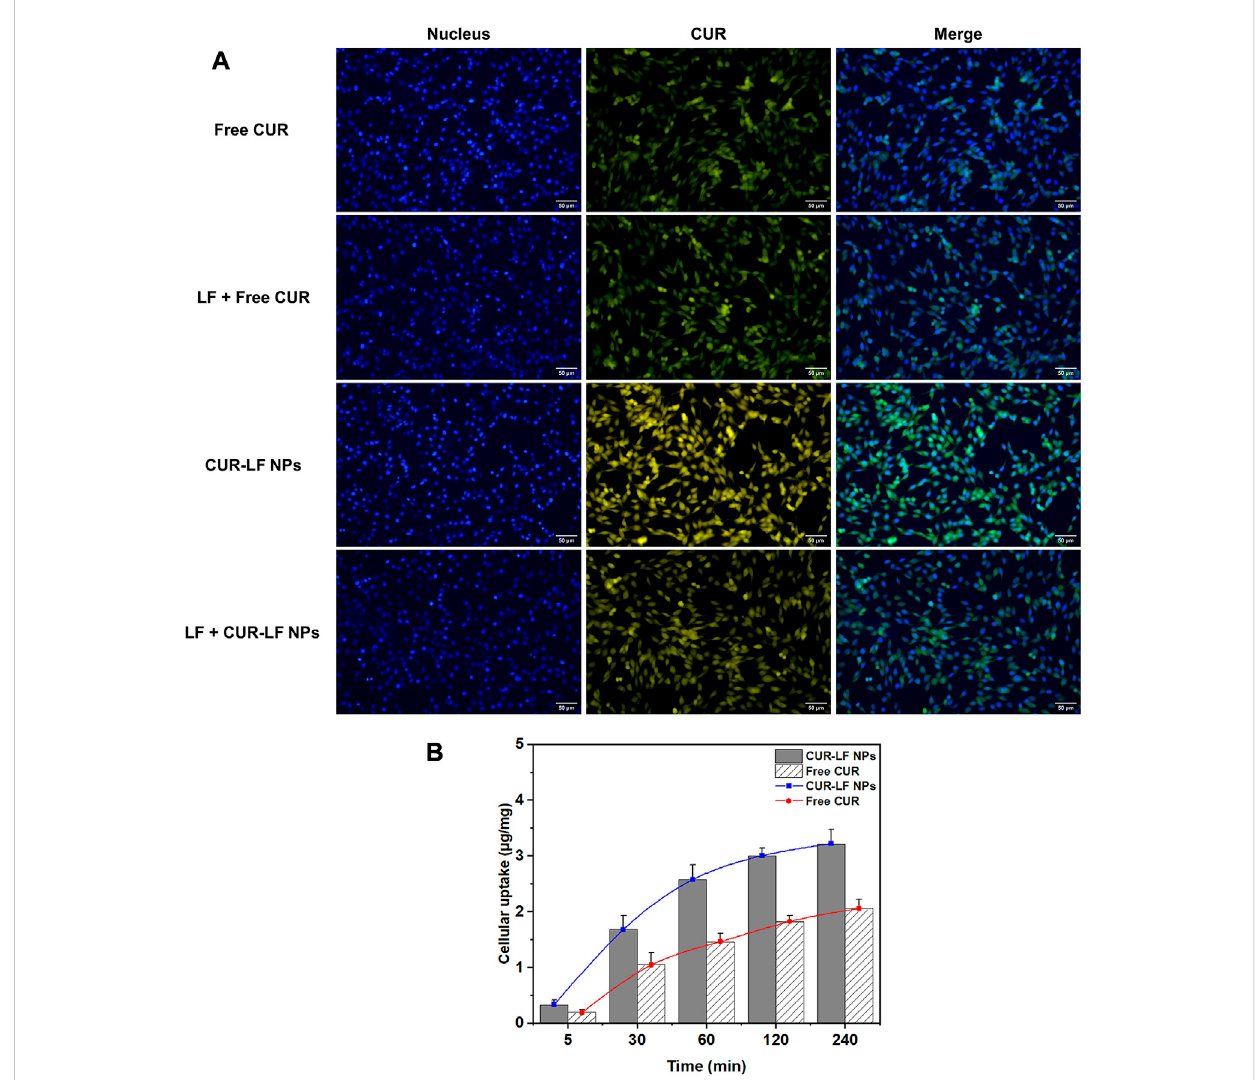
FIGURE 4 Cellular uptake of different curcumin formulations in PC12 cells (A) Fluorescence microscopy qualitative analysis of cellular uptake after incubation for 60 min with free curcumin and CUR-LF NPs with or without lactoferrin pretreatmentat the concentration of 20 μ M; (B) HPLC quantitative analysis of cellular uptake after incubation for 5, 30, 60, 120, and 240 min with the concentration of 20 μ M. Data were presented as mean ± SD ( n =